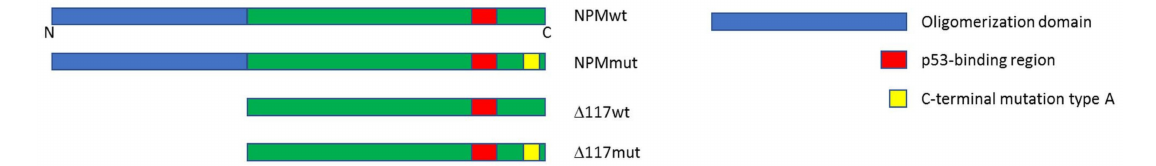
Scheme 1. Comparison of used NPM variants. List of abbreviations is in Table